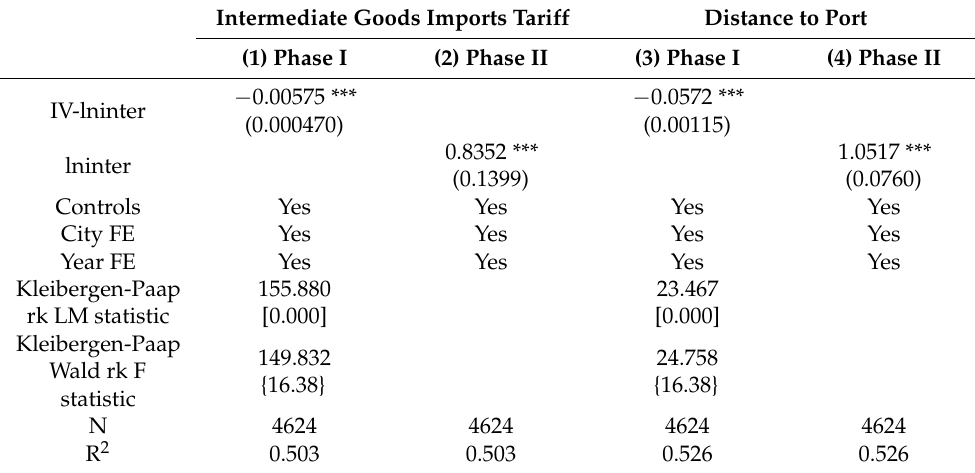
Table 4. Test of instrumental variables method.